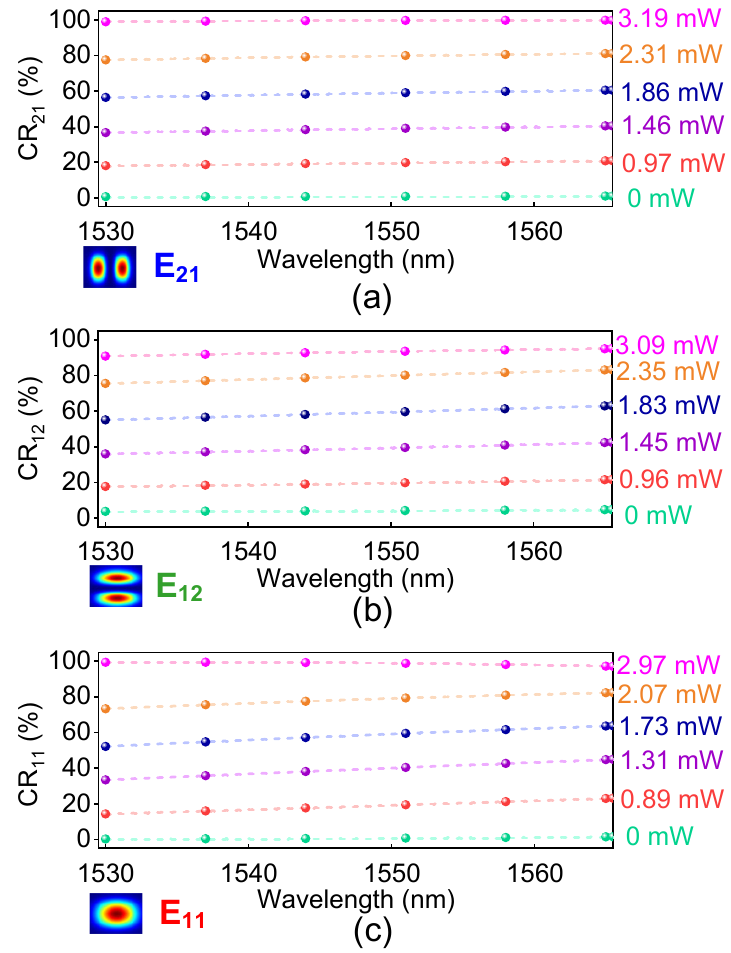
Figure 11. The operating wavelength for switching ( a ) the E 21, ( b ) the E 12 and ( c ) the E 11 modes of the device against the applied electric power to the GEHs.